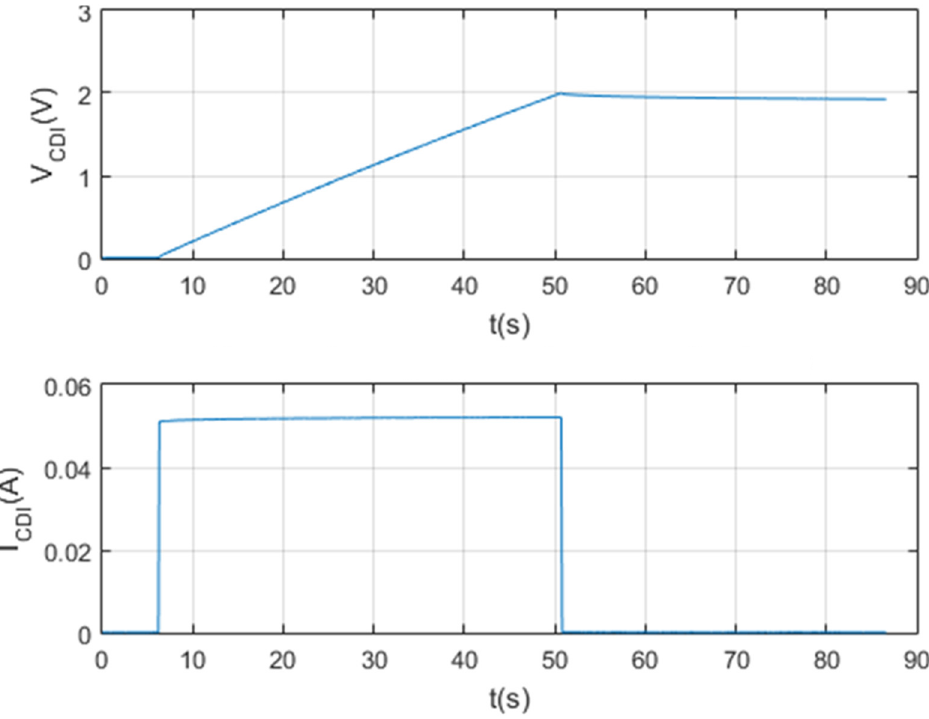
Figure 11. Load and self-discharge test at Vc_max = 2 V and Ic = 0.05 A.